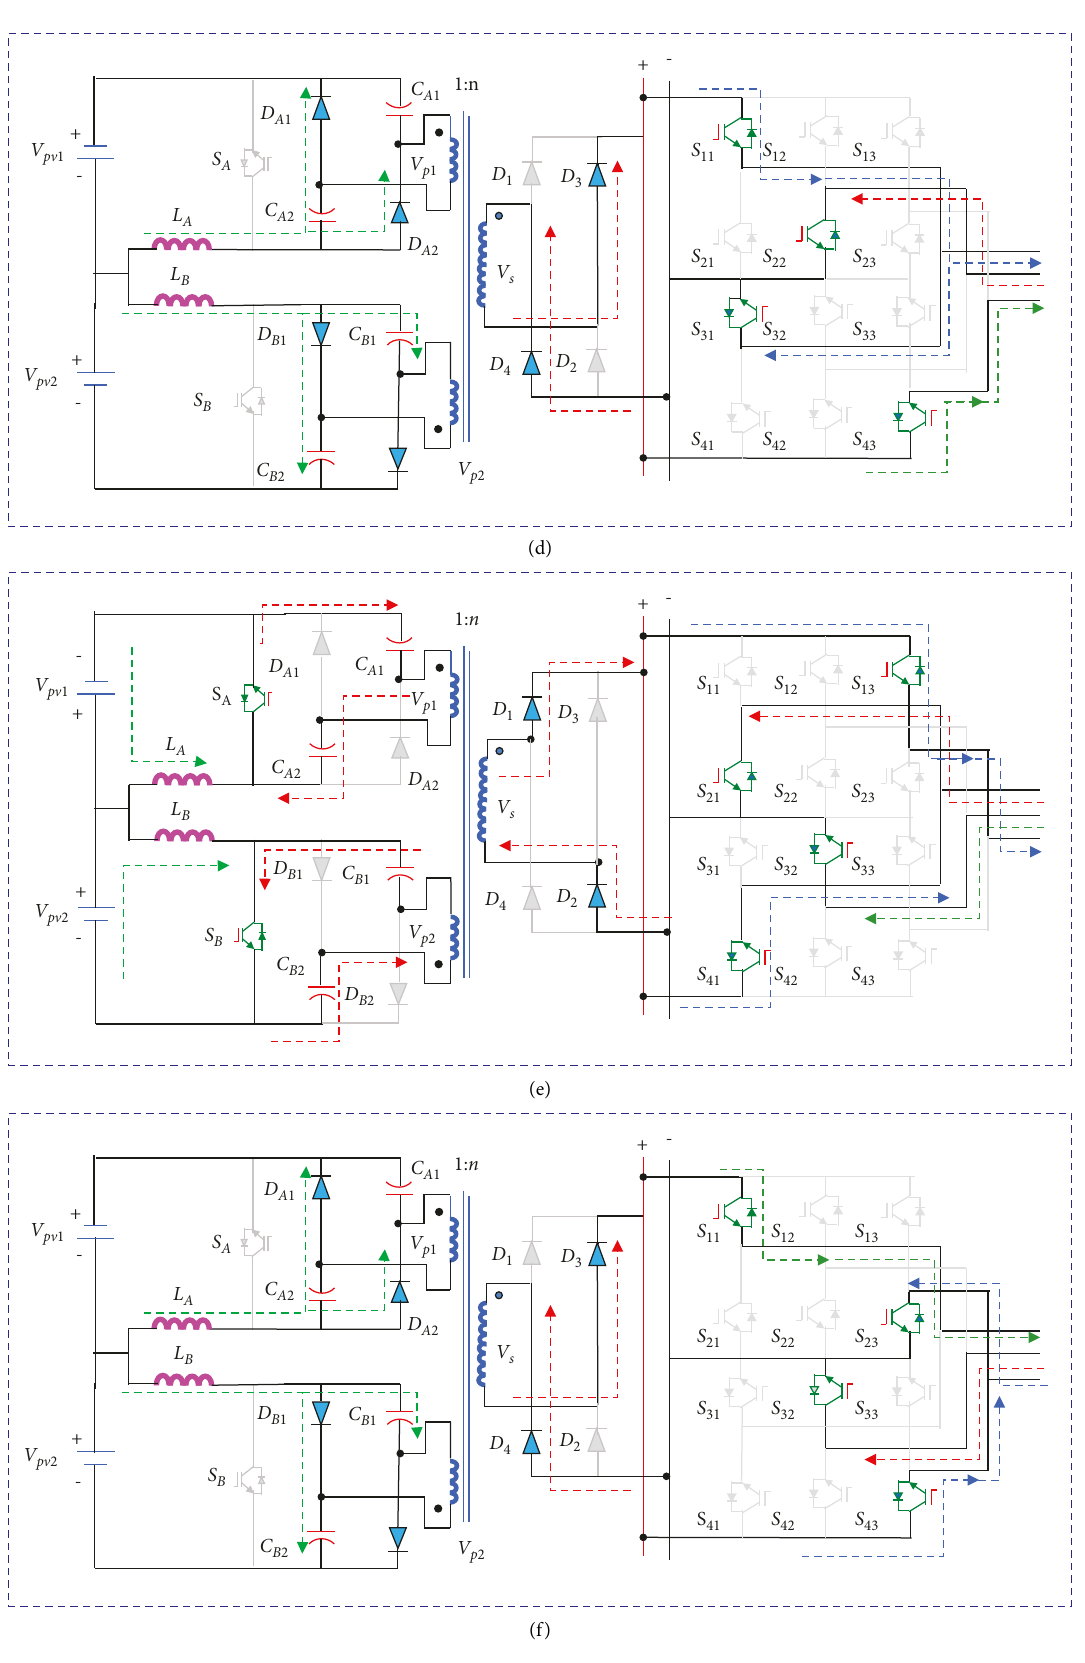
Figure 11: Equivalent circuit and current flow path for mode 7 to mode 12 operation. Equivalent circuit of (a) mode 7 operation, (b) mode 8 operation, (c) mode 9 operation, (d) mode 10 operation, (e) mode 11 operation, and (f) mode 12